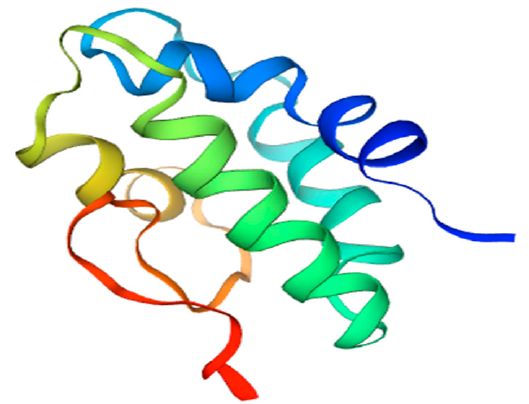
Figure 4. 3D model of tomato Sola l 3 structure. Homology Model based on nsLPT derived from Nicotiana tabacum, Seq Identity 71.43%. Table 6. Members of the nsLTP.